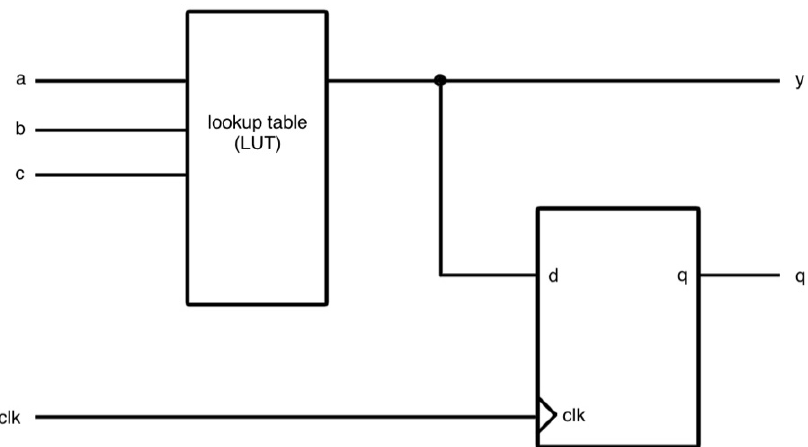
Figure 2. A diagram of the three-input LUT.